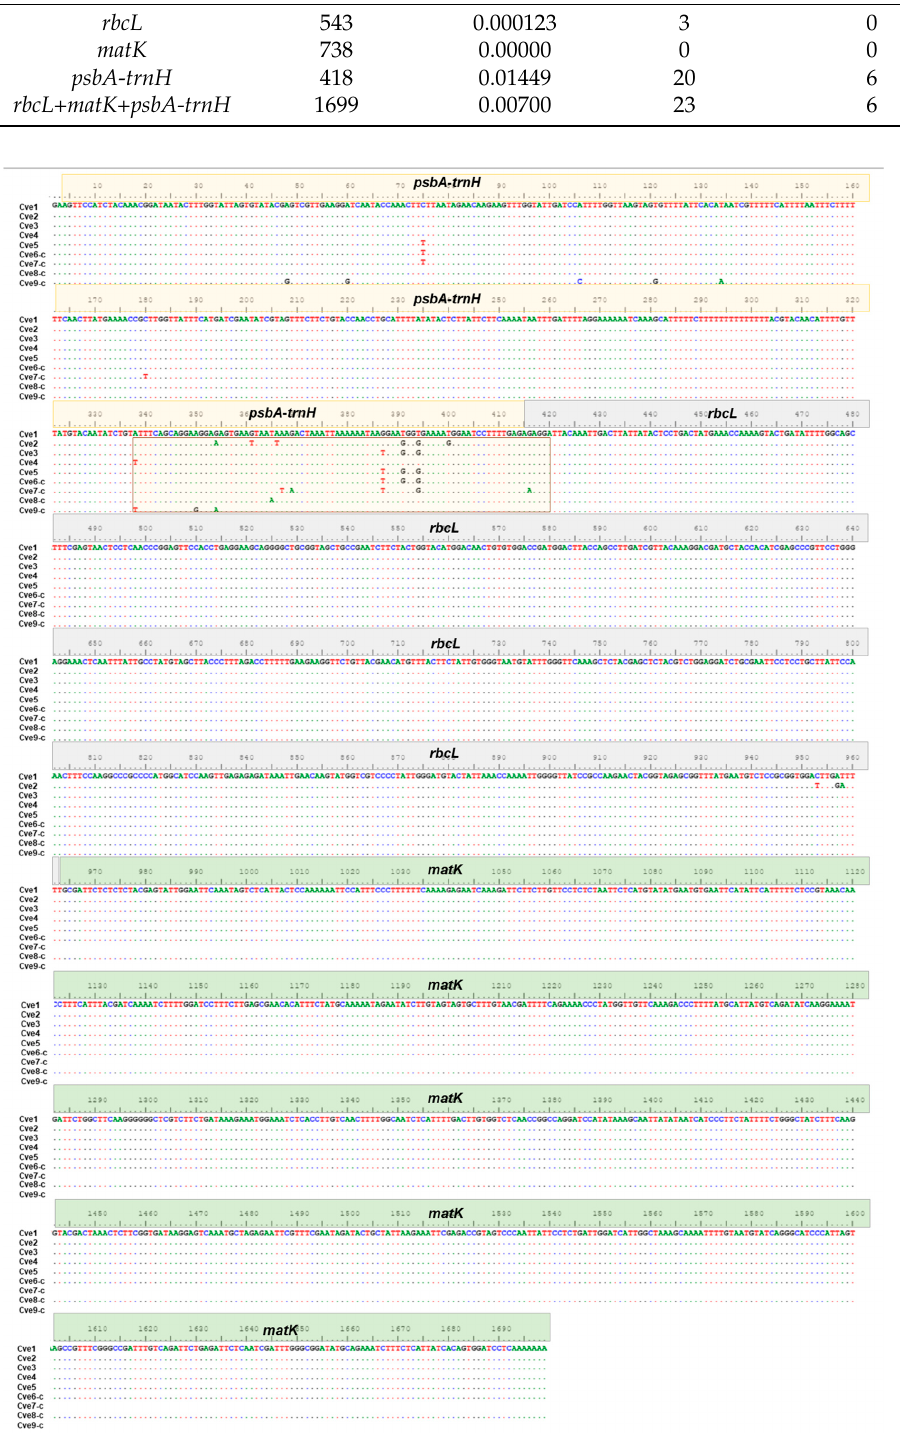
Figure 2. Multiple alignments of the nucleotide sequences of the markers matK , rbcL and psbA - trnH of cultivated (Cve1–Cve5) and commercial samples (Cve6-c–Cve9-c) of Cinnamomum verum . The dots indicate the consensus nucleotides, and the Boxes shown the variable region observed in pbsA - trnH.psbA - trnH (1–431 bp), rbcL (432–974 bp) and matK (975–1712 bp).